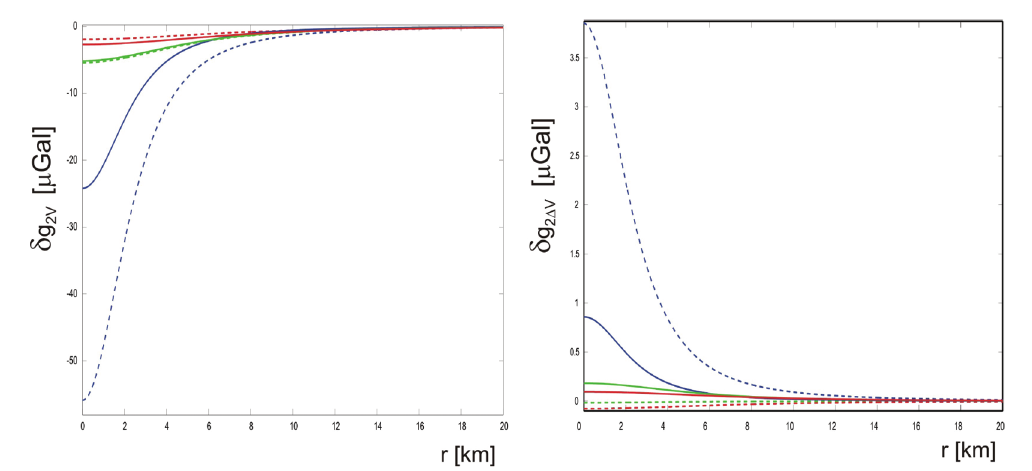
Fig. 3. The δ g 2 ∆ V and δ g 2V terms when no mass is added inside the source using the heterogeneity model (dashed lines) for a source at three different depths: 3 km (blue), 6.5 km (green), 9 km (red). The analytical so- lutions for homogeneous medium are also shown (solid